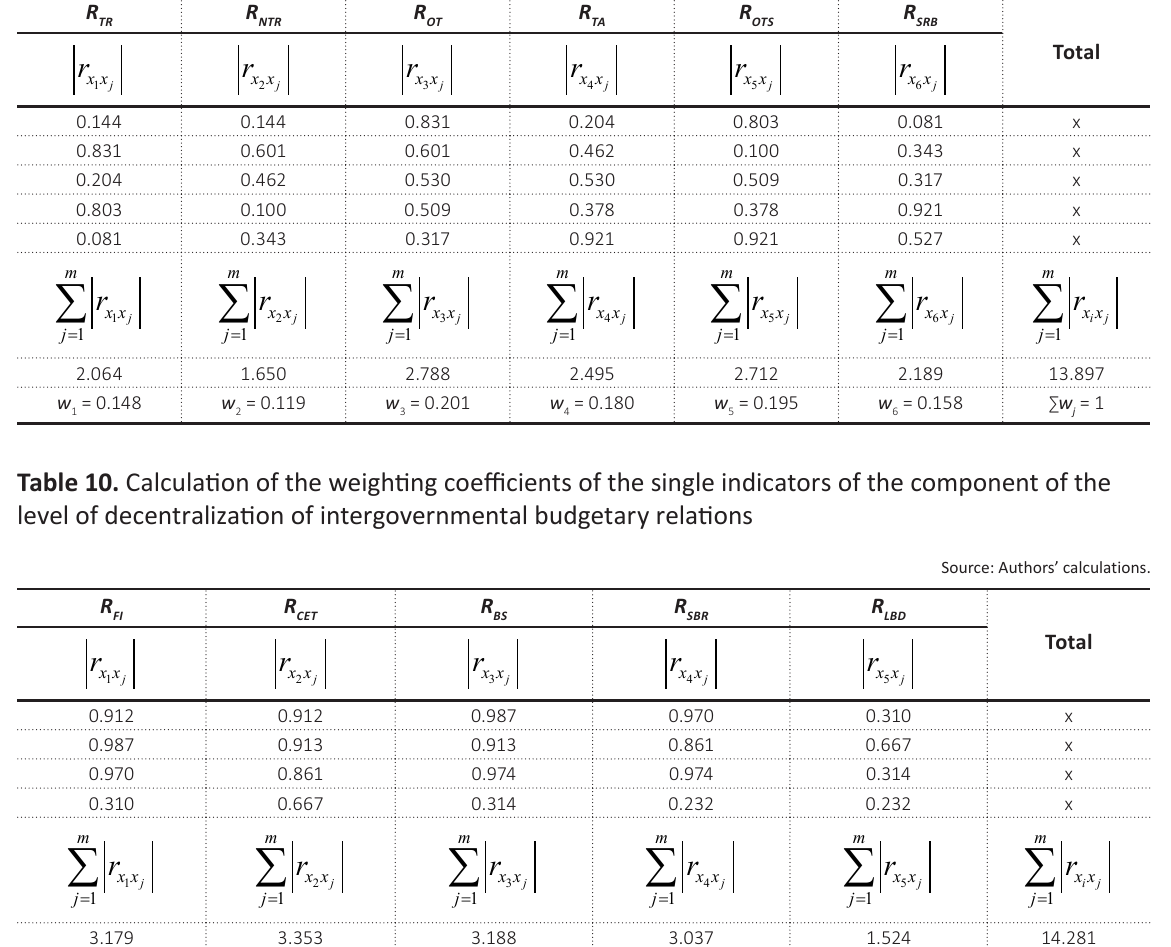
Table 9. Calculation of the weighting coefficients of the component of the level of fiscal policy decentralization for the structure of local budgets